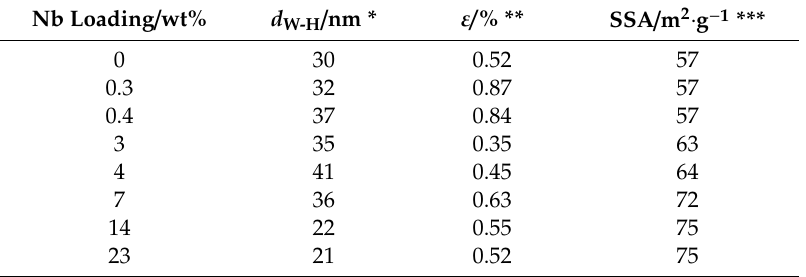
Table 1. Structural and textural parameters of samples from the Nb / K-OMS-2